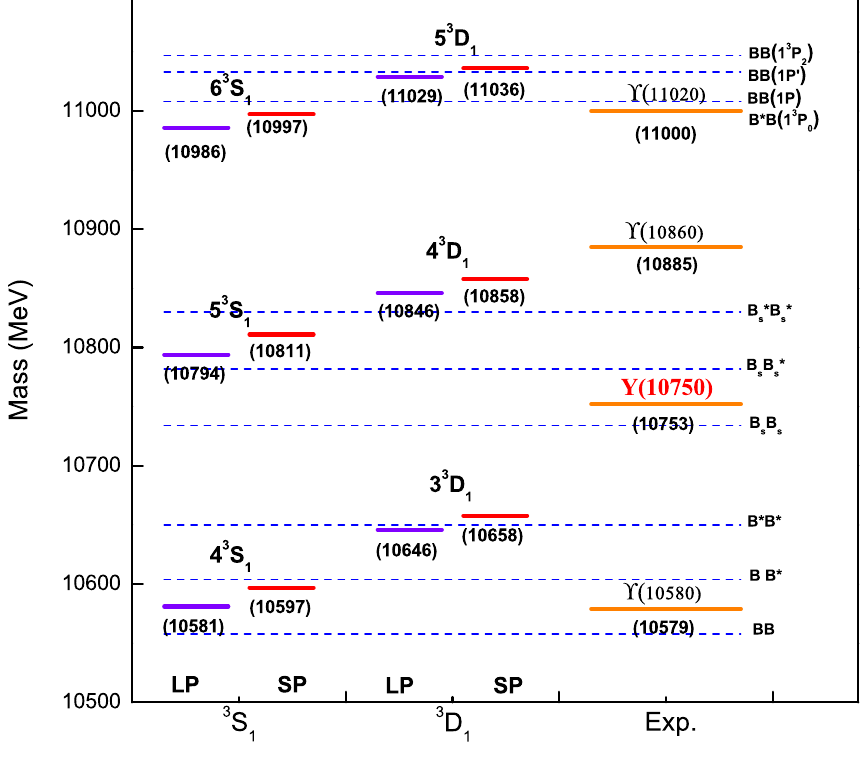
Fig. 1 The spectrum of the higher vector bottomonium above the B ¯ B threshold predicted within both screened potential (SP) and liner potential (LP) models. For a comparison, the experimental observations [1,14] are plotted in the figure as